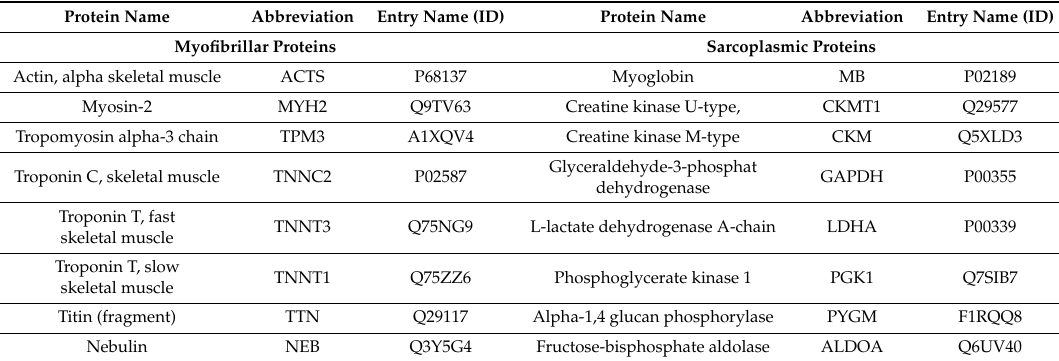
Table 1. The porcine proteins subjected to in silico